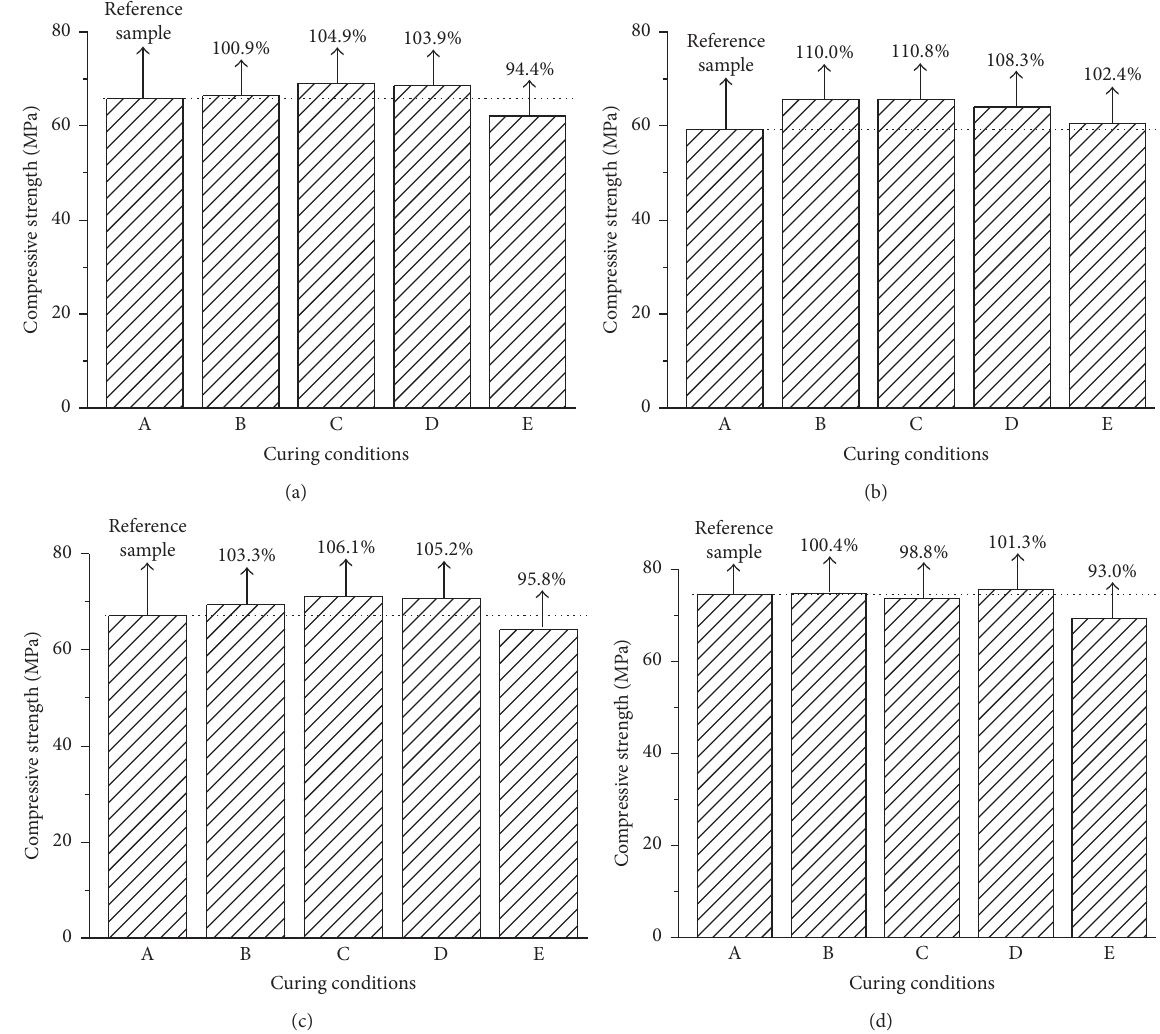
Figure 5: Compressive strength of the concretes cured under different curing conditions at the age of 360 days. Samples: (a) plain cement, (b) 45% FA, (c) 45% GGBS, and (d) 12%